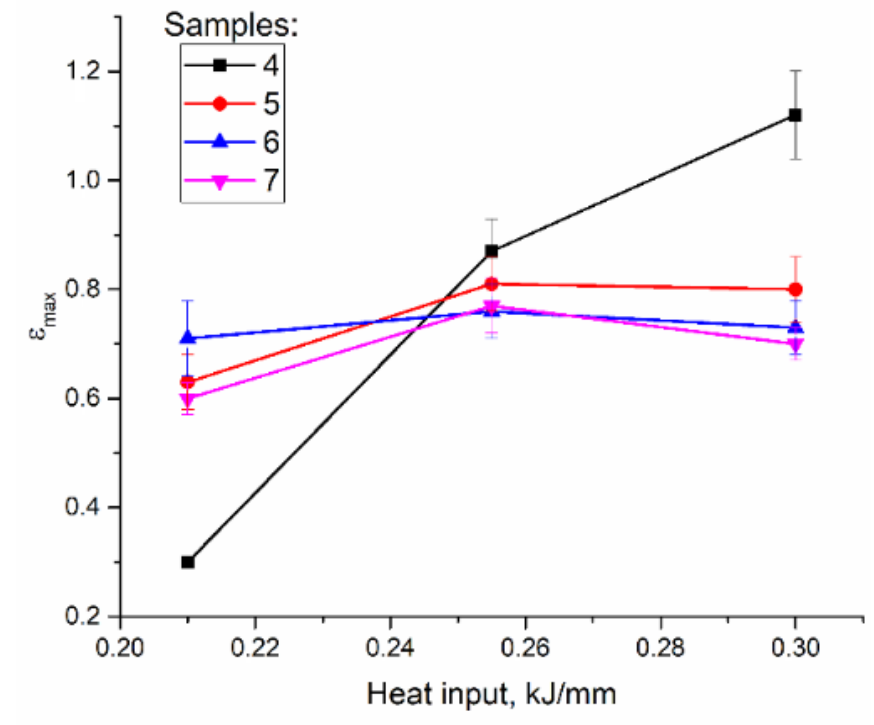
Figure 14. Strain-to-fracture vs. heat input dependencies. Samples 5, 6, and 7 tested with their tensile axes orientation perpendicular to the wall height (Figure 2, pos. 5, 6 and 7) demonstrated different mechanical characteristic dependencies on the wall height and heat input.